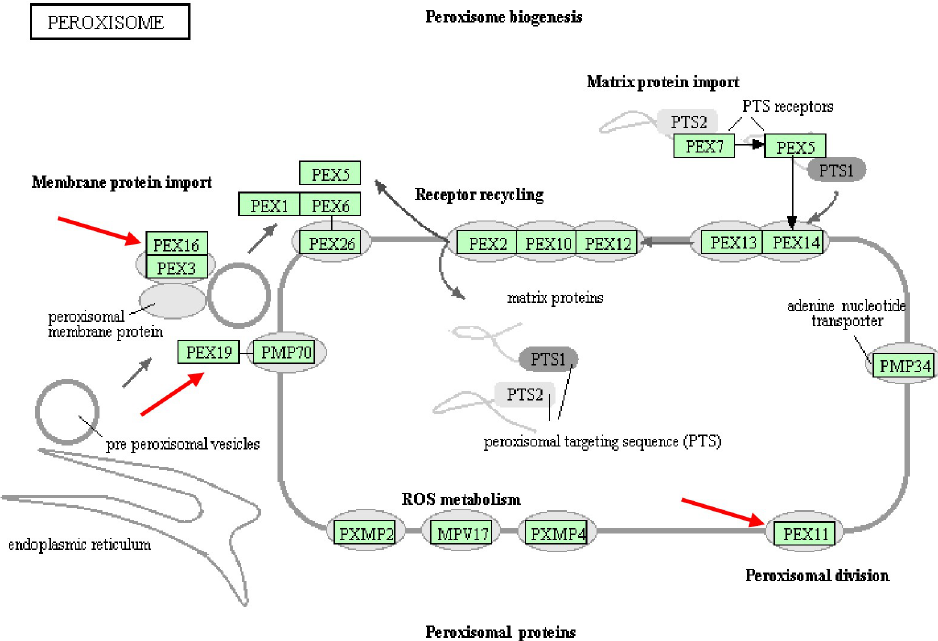
Fig 7. Peroxidase signaling pathway map. The gene indicated by the arrow is a key gene for peroxisome biosynthesis, and the WAE group and the control group are differentially expressed.